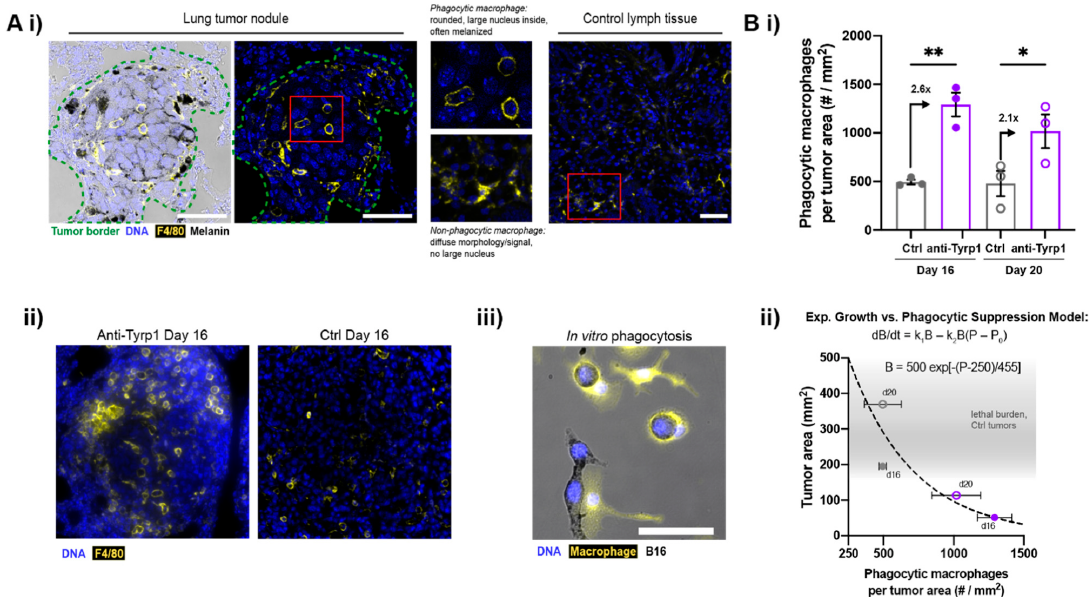
Figure 3. Tumor-opsonizing antibodies increase macrophage infiltration in tumors. ( A ) Phagocytic macrophages in treated CD47 KO lung tumor nodules. (i) Confocal images of anti-Tyrp1-treated CD47 KO tumors show F4/80+ macrophages that are rounded in morphology and contain melanin and large DAPI+ nuclei, indicating phagocytosis of B16F10 cells. F4/80+ macrophages in control lymph tissue (lymphatics-localized) show diffuse, non-phagocytic morphology. (ii) Treated lung nodules show more phagocytic macrophages than untreated control lungs. (iii) Rounded macrophage in vitro after engulfing an opsonized B16F10 cell. Scale: 50 µ m. ( B ) (i) Phagocytic macrophages per tumor area increase with anti-Tyrp1 treatment in CD47 KO lung tumor nodules. Mean ± s.e.m. (* p < 0.05, ** p < 0.01, Student’s t -test, n = 3 representative samples per group, closed circles indicate day 16 samples and open circles indicate day 20 samples). (ii) Relationship between the lung tumor area and density of phagocytic macrophages: exponential-type growth versus phagocytic suppression. Tumor burden, B, is modelled by an ordinary differential equation in which growth is suppressed by phagocytic interactors, P. P 0 refers to inactivated